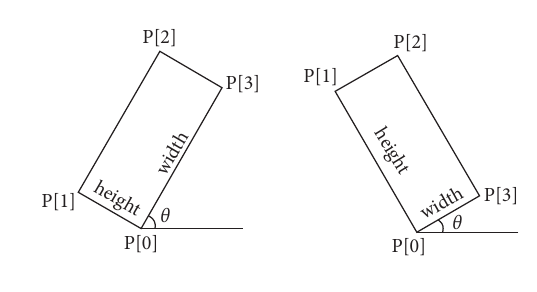
Figure 10: Describing of angle θ of rectangle.